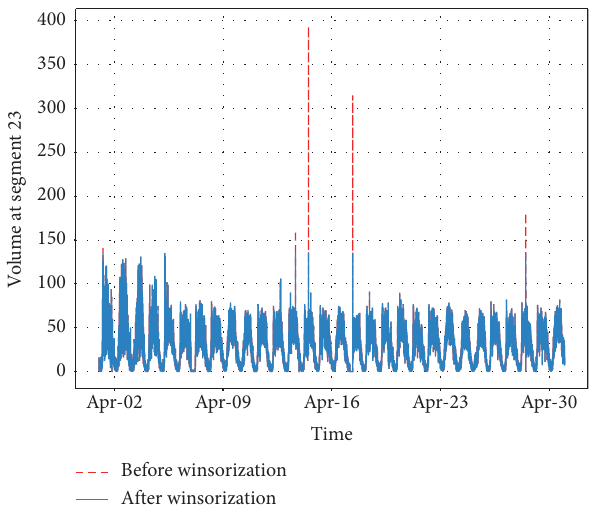
Figure 2: Volume values from segment 23 of study area before and after